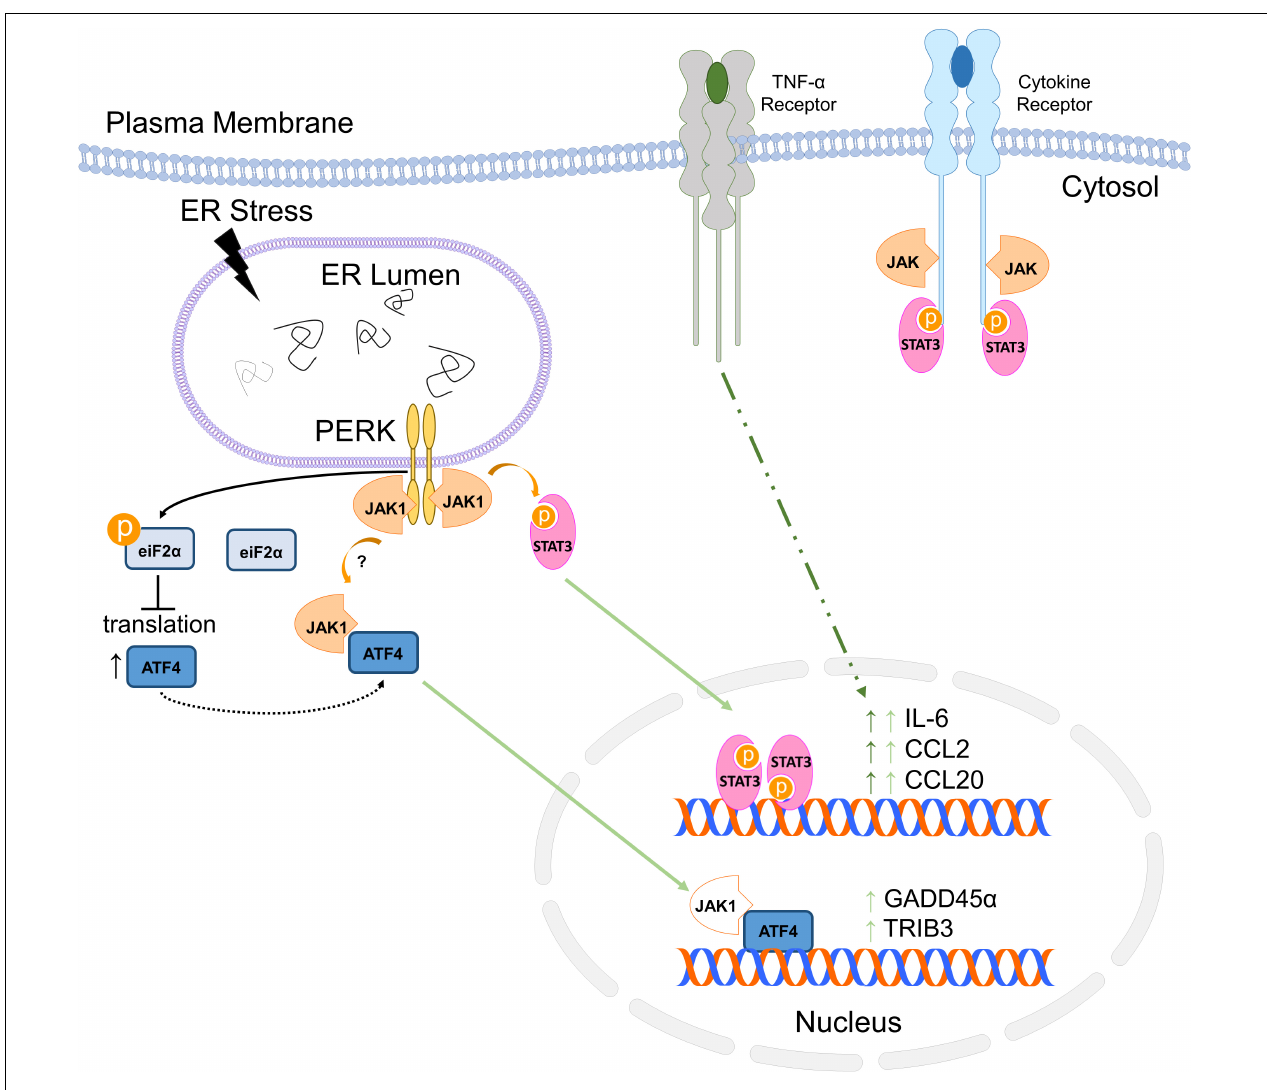
FIGURE 7 | Summary of ER stress-induced JAK1-dependent